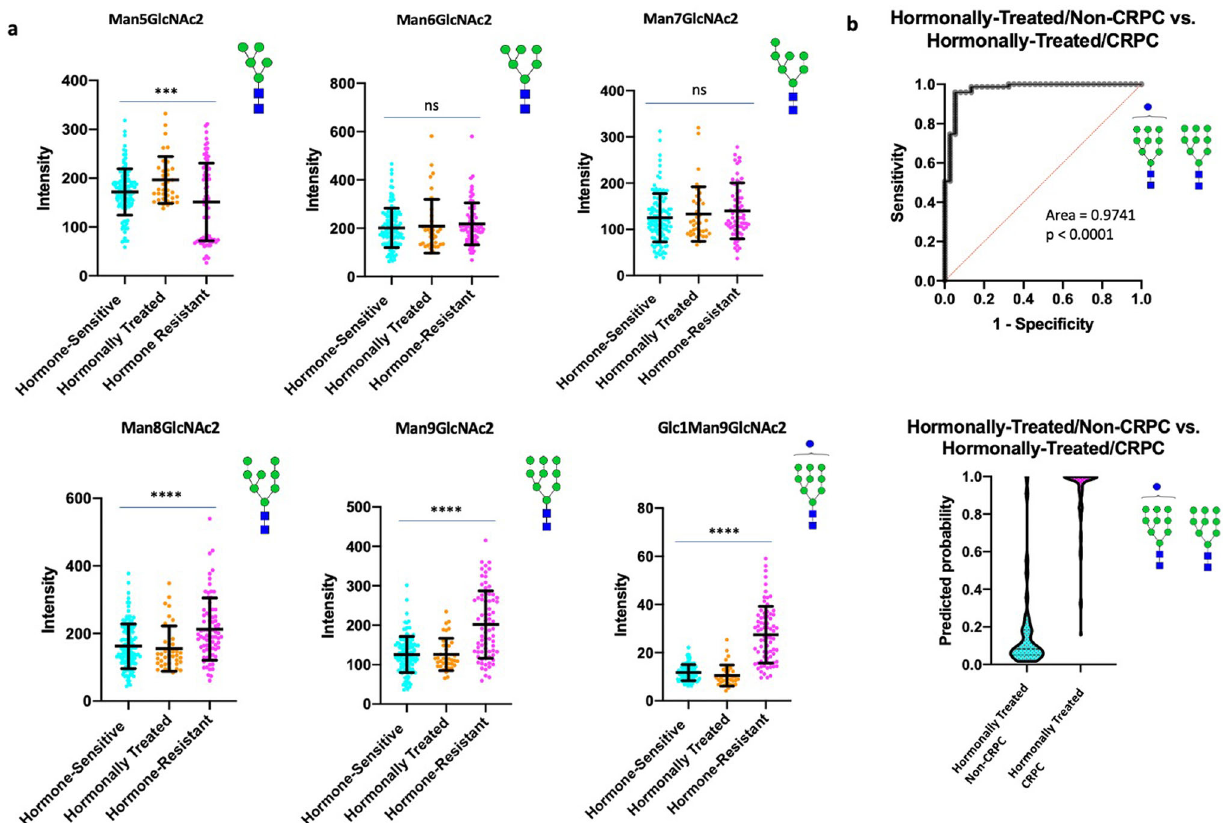
Fig. 6 High mannose structures associated with resistance to hormonal therapy. a Scatter plot comparisons of Man5 – 9 abundance in hormone-sensitive ( n = 120), hormonally-treated ( n = 37), and hormone-resistant ( n = 75) tumor regions. One-way ANOVA was used for multiple comparisons with p < 0.05 considered signi fi cant. The following system was used to denote signi fi cance: p < 0.05 (*), p < 0.01 (**), p < 0.0001 (***), p < 0.00001 (****). Error bars correspond to standard deviation. b (Top) ROC curve demonstrating the predictive power (AUC = 0.9741, p < 0.0001) of Man9 and Glc1Man9 for disease recurrence (Bottom) Violin plot demonstrating the probability of Man9 and Glc1Man9 for predicting disease recurrence (Center line represents median, Upper and lower bars represent 75th and 25th quartiles,